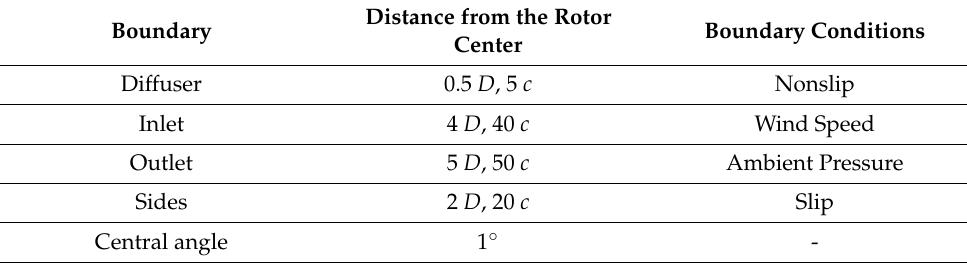
Table 1. Domain and boundary conditions ( D : rotor diameter, c : diffuser chord length).